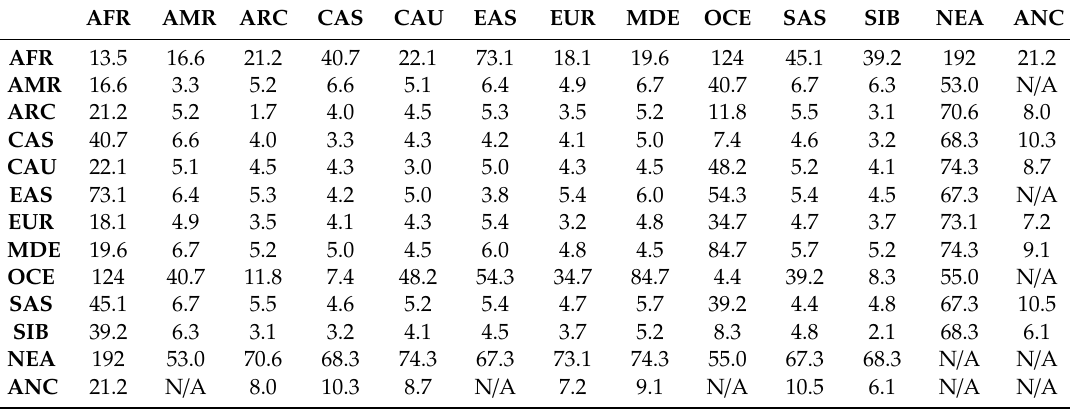
Table 5. Time (in 1000 years) for last common ancestors of shared IBD fragments between populations from major geographical